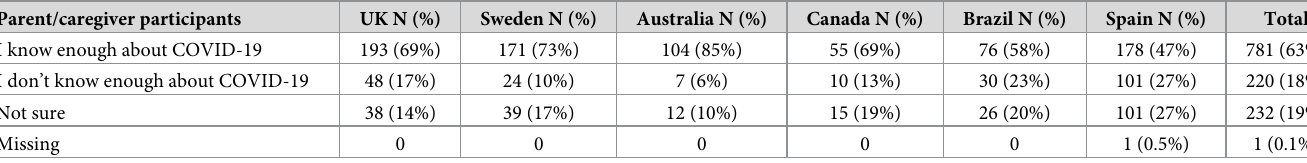
Table 8. Parent/caregivers’ self-report of how much they know about COVID-19.